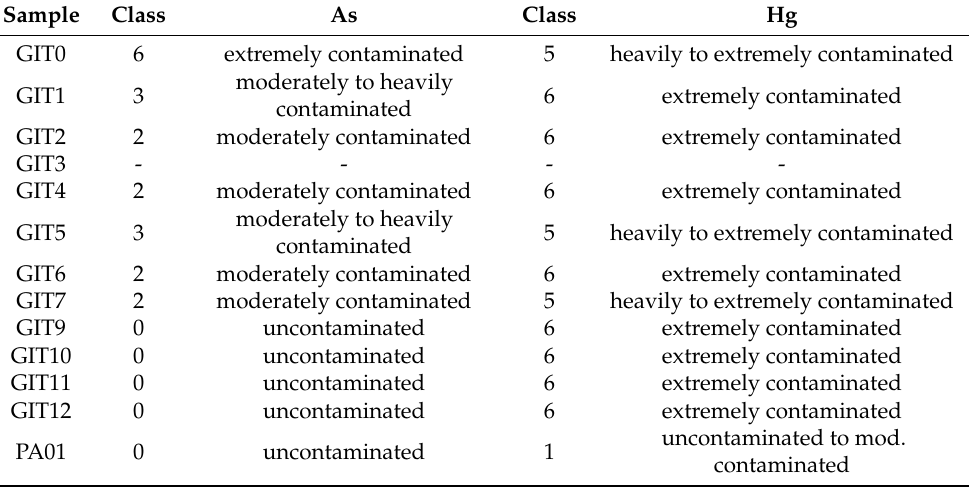
Table 3. Classes of As and Hg according to the I geo values of the FdC stream sediments. The classes are, according to [28]: Class 0 = “uncontaminated”; Class 1 = “from uncontaminated to moderately contaminated”; Class 2 = “moderately contaminated”; Class 3 = “from moderately contaminated to heavily contaminated”; Class 4 = “heavily contaminated”; Class 5 = “from heavily to extremely contaminated”; Class 6 = “extremely